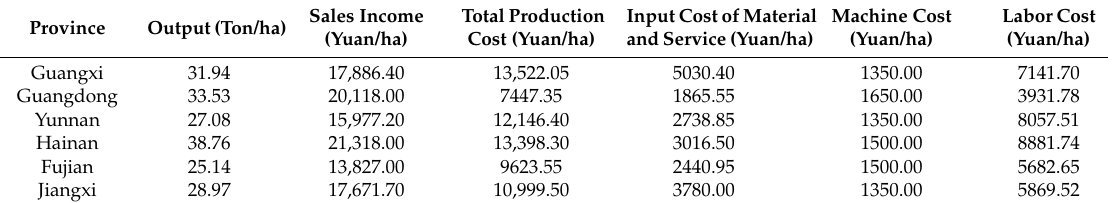
Table 4. Cassava production input–output analysis of six provinces in 2014.